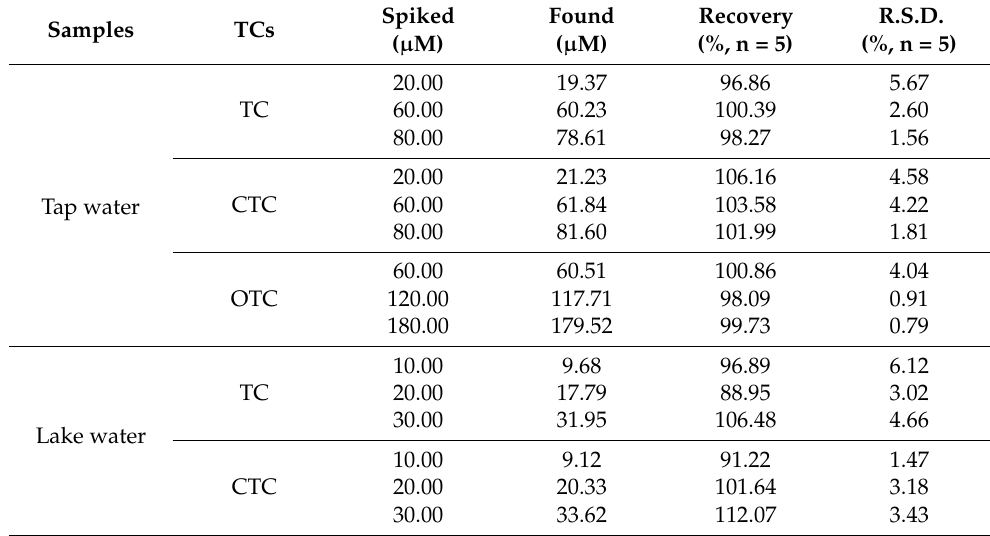
Table 1. Analysis of TCs with the proposed biomass − based C − dots − based analytical platform in real lake and tap water samples (n =